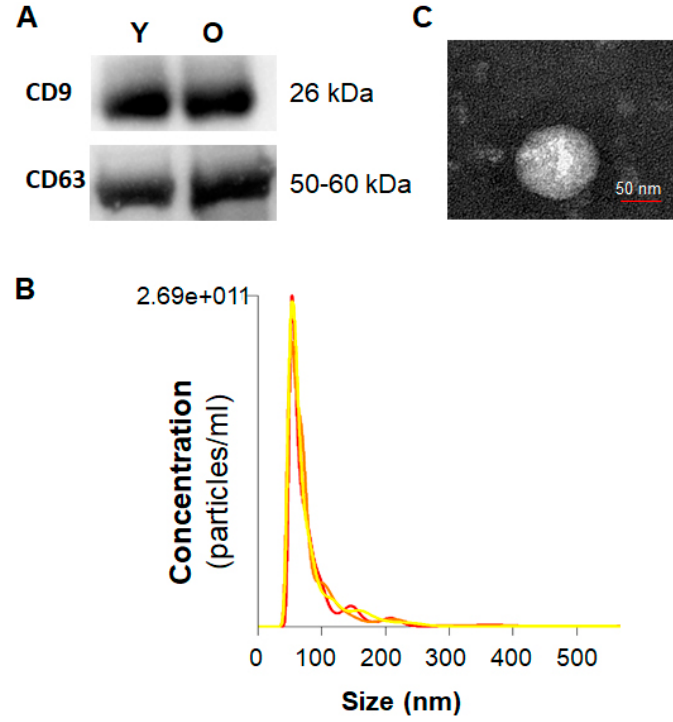
Figure 1. Characterization of serum exosomes. ( A ) Western blotting for CD63 and CD9 in serum exosomes isolated from young and old rats. ( B ) Average overall size distribution of exosomes from serum of old rats using the Nanoparticle Tracking Analysis. ( C ) Representative transmission electron microscopy image showing the typical morphology and size range of exosomes from serum of old rat. Y, serum exosomes from young rats; O, serum exosomes from old rats.